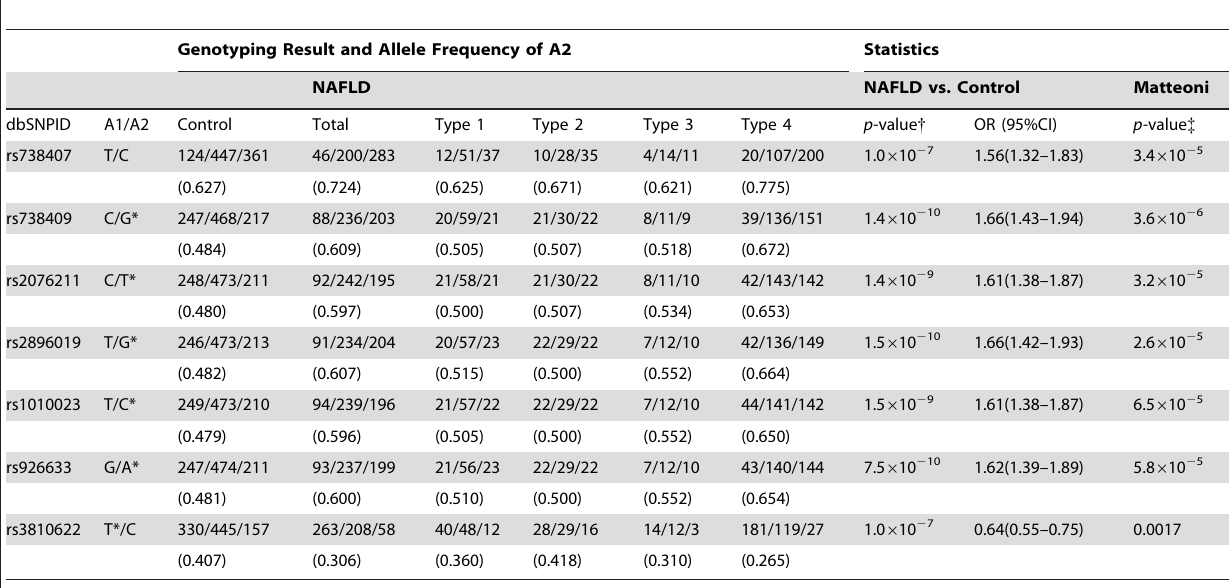
Table 2. List of the SNP markers in the PNPLA3 locus at chromosome 22q showing genome wide significance.